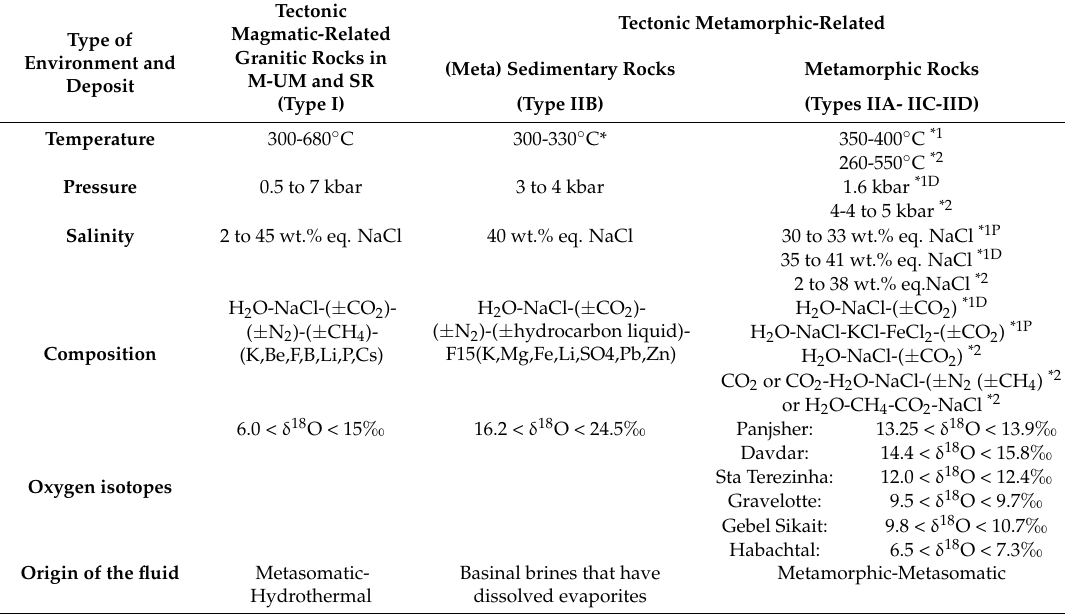
Table 3. Fluid inclusion data and oxygen isotope composition of several emerald deposits worldwide following the enhanced classification proposed for emerald deposits.